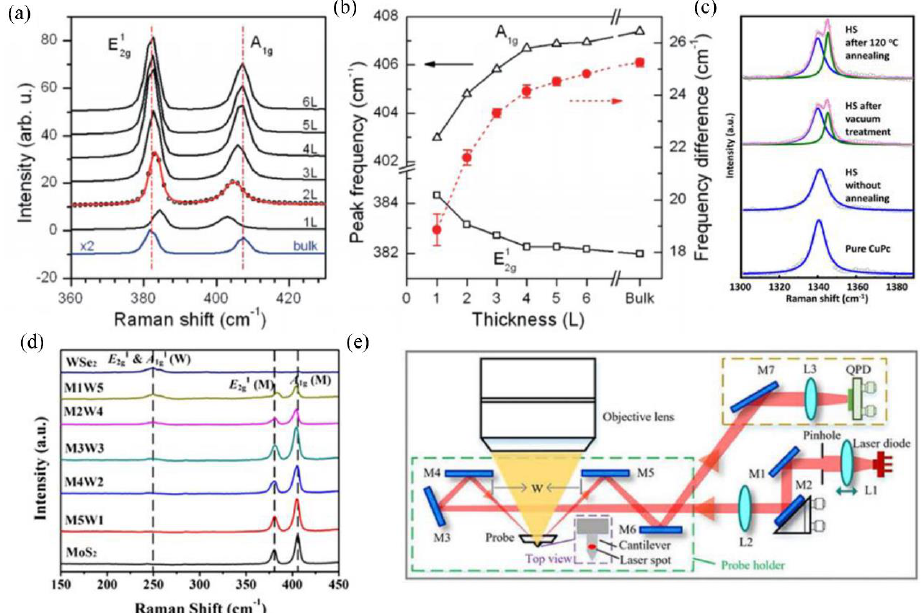
Figure 3. ( a ) Raman spectra of MoS 2 [71] . ( b ) Variation of frequencies of 𝐸 2𝑔1 and A 1g Raman modes with layer thickness. Reprinted with the permission of Ref. [71]. Copyright 2010,